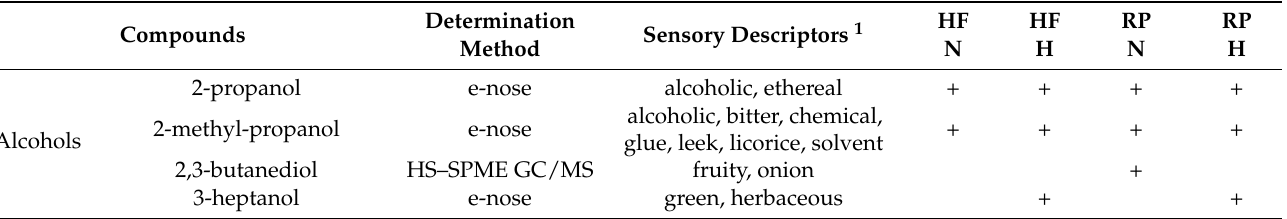
Table 3. Volatile organic compounds in fresh cheese samples determined using an electronic nose with D > 0.9500 and via HS–SPME